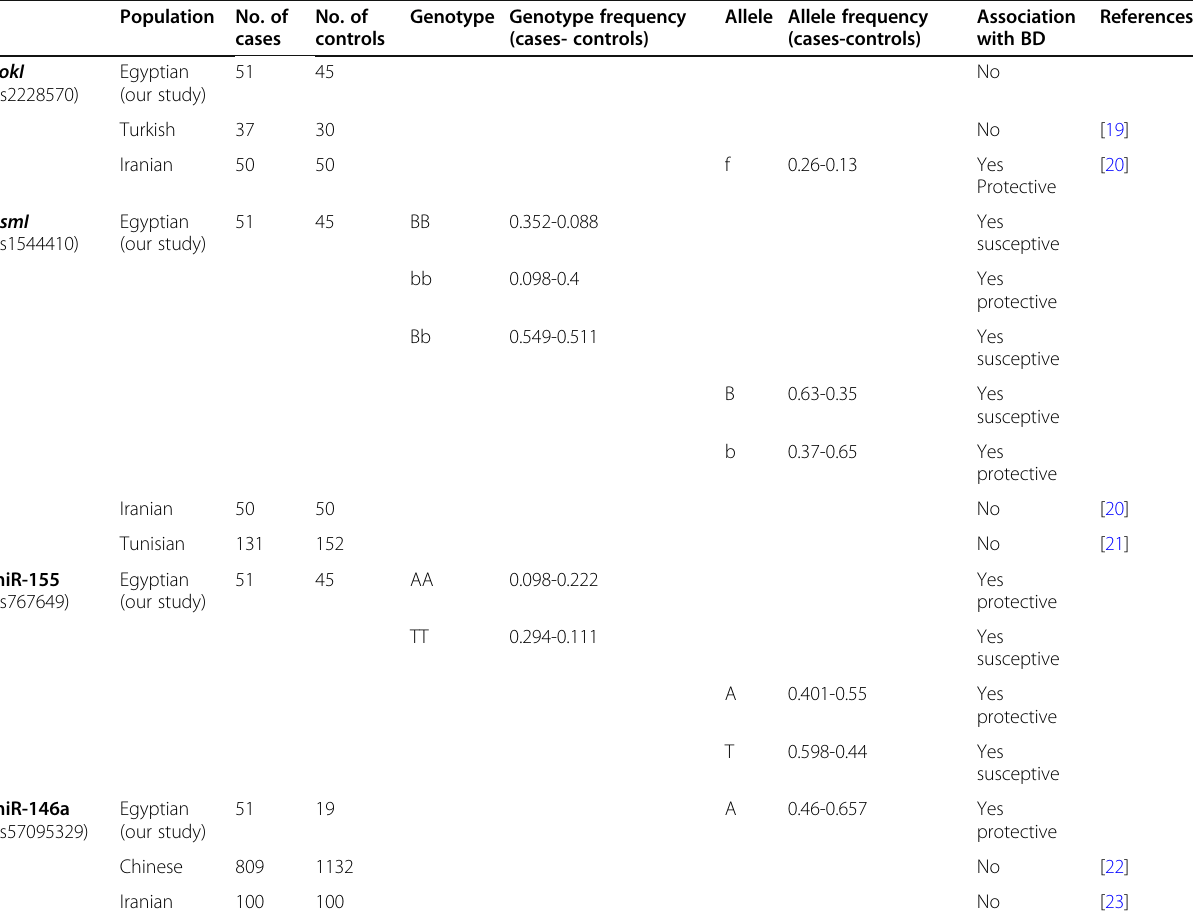
Table 3 Association status with BD of this study and previous studies Population No. of No. of Genotype Genotype frequency cases controls (cases- controls)